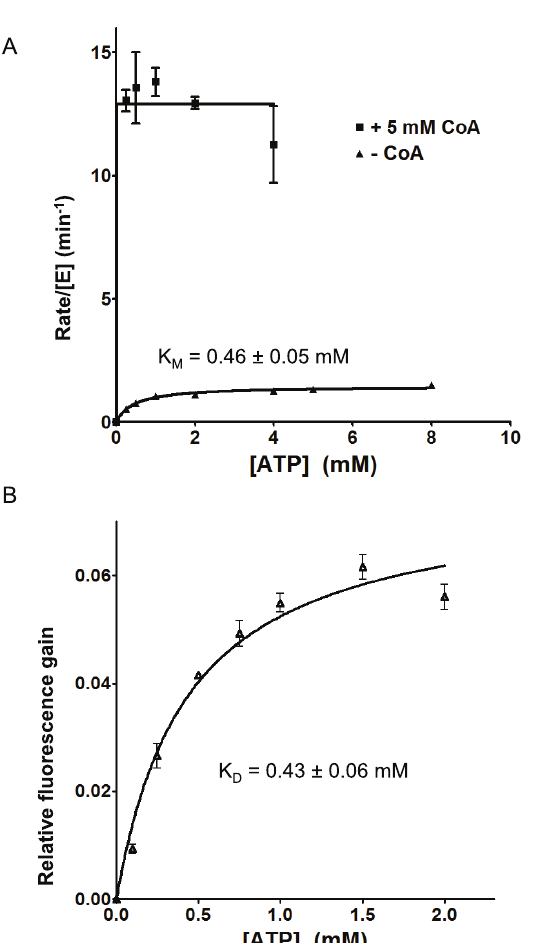
Figure 3. Rate of pyrophosphate release and ATP-induced fluorescence gain. The reaction solutions contained 0.005 mM wild-type BcDltA, specified concentrations of ATP and CoA, 5 mM D-alanine, 0.1 M KCl, 0.01 M MgCl , 0.05 M Hepes-NaOH buffer 2 at pH 7.2, 5 unit/mL of yeast inorganic pyrophosphatase. A . The initial rates of pyrophosphate accumulation divided by the BcDltA concentration are shown. The reaction rates in the presence of CoA are taken from a previous study 24 . B . Relative fluorescence gains as a fraction of the fluorescence intensity in the absence of ATP are